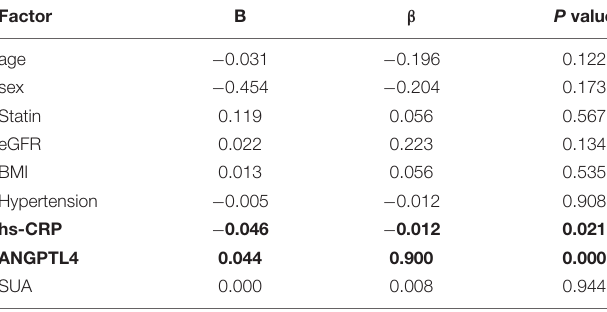
TABLE 6 | Stepwise multiple regression analysis detecting independent contributor to